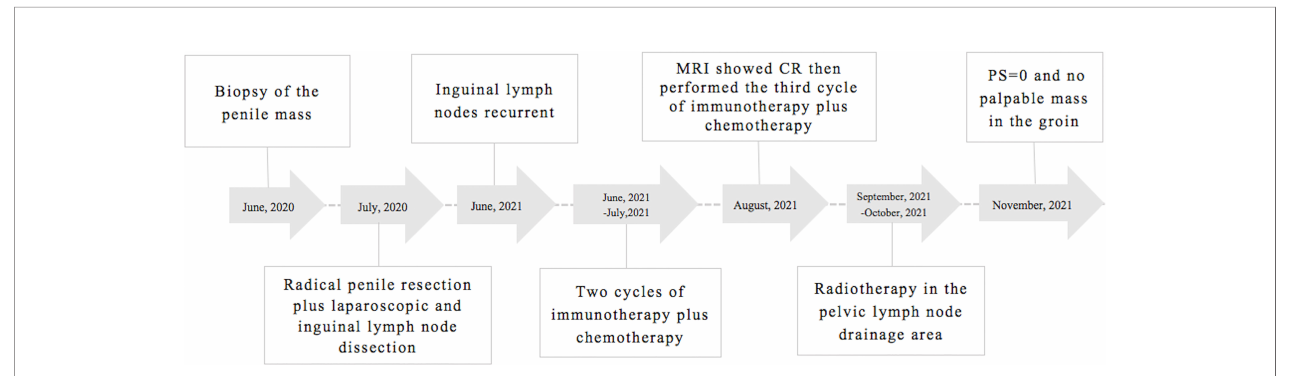
FIGURE 1 | Treatment timeline of the